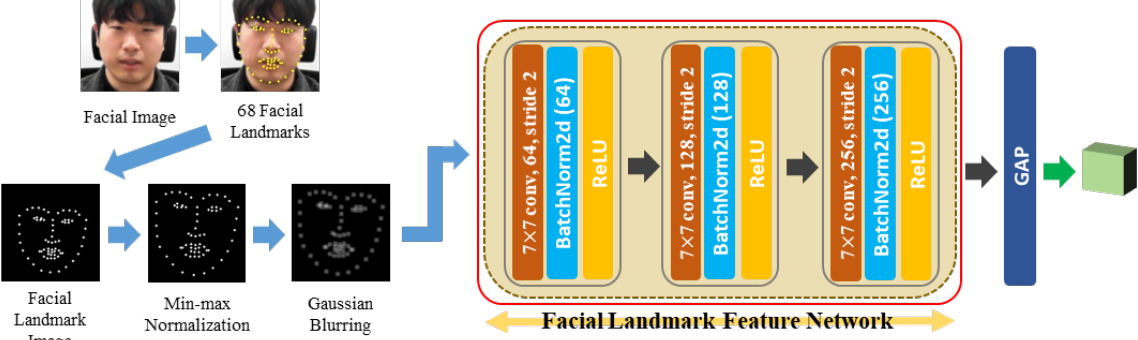
Figure 4. Facial landmark feature extraction process. A simple network with three convolutional layers is used to extract the facial landmark feature. GAP: global average